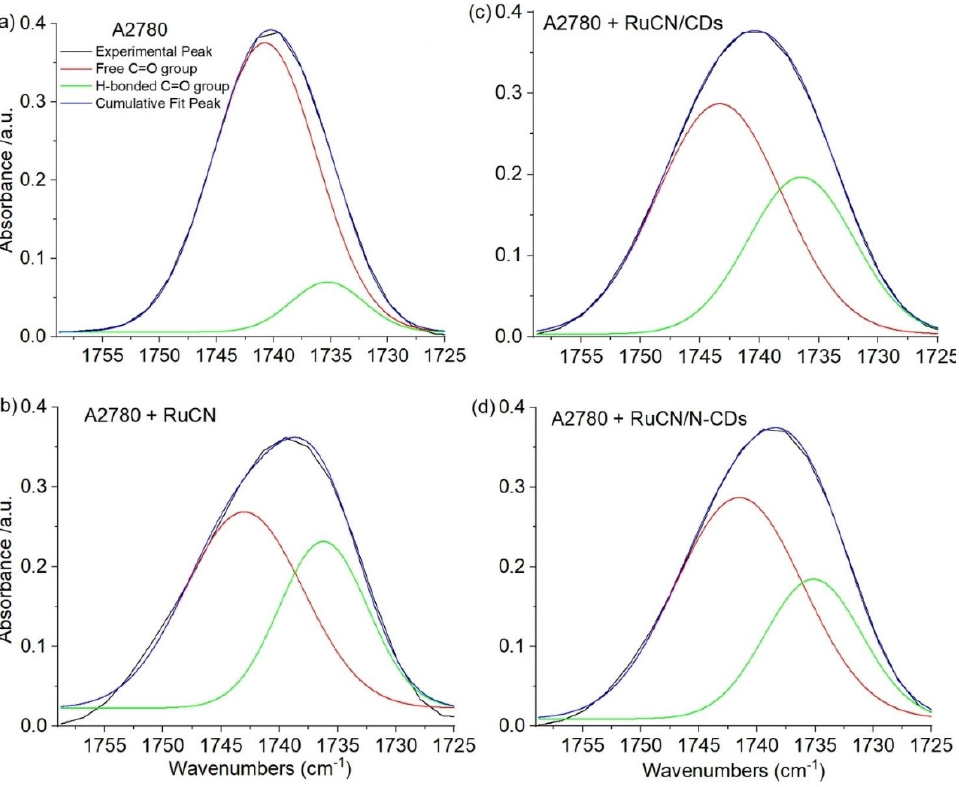
Figure 9. Deconvolved spectrum of C=O vibration band region (1725-1760 cm − 1 ) of untreated cells ( a ) after the treatment with RuCN ( b ), RuCN/CDs ( c ), and RuCN/N-CDs ( d ). The black curve shows the original experimental peak, whereas the purple line represents the cumulative fit peak, i.e., the sum of the subcomponent contributions (free C=O group (red line) and H-bonded C=O group (green line)).